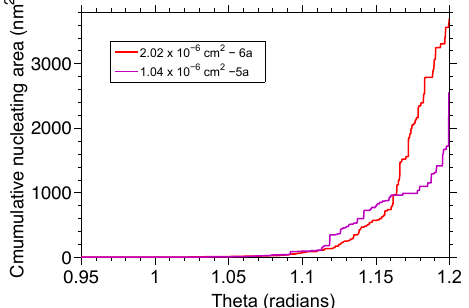
Figure 9. Cumulative ice nucleating surface areas from application of Eq. (11) to modeled average g distributions from systems 6a (red) and 5a (purple) in Fig. 5, taken from cold plate measurements of il- lite in droplets from Broadley et al. (2012), plotted against the criti- cal contact angle range. At low contact angles the two systems have close total nucleating surface areas. This explains the similar on- set of freezing before the eventual divergence at lower temperature (larger contact